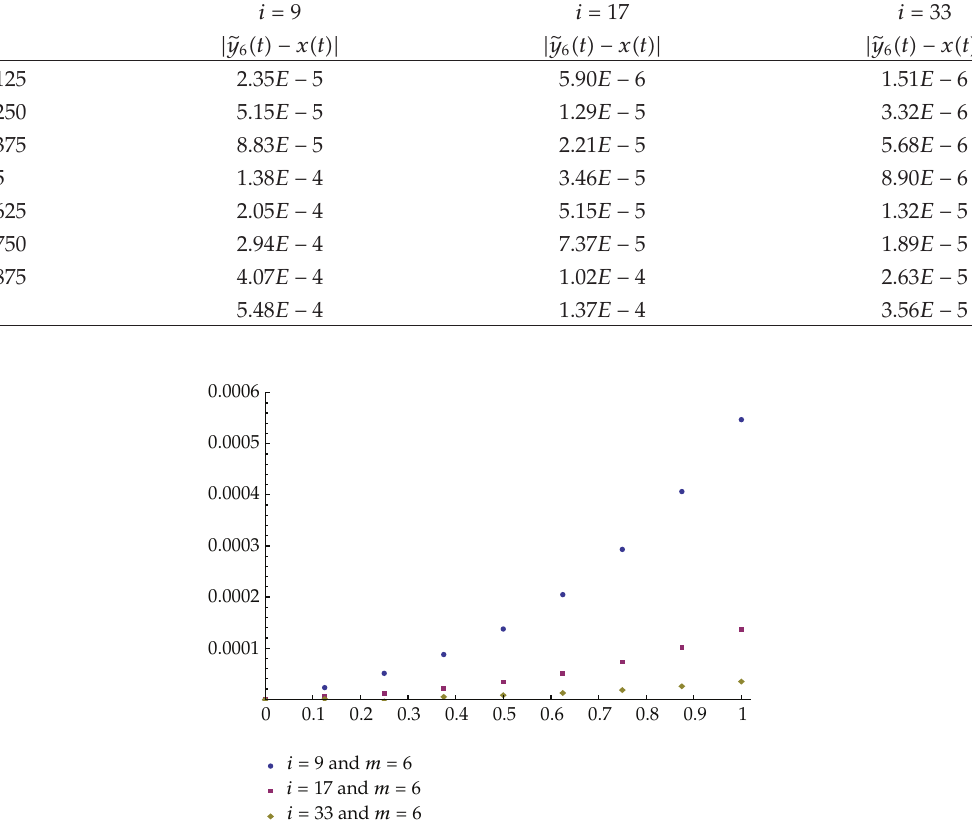
Figure 2: The plot of absolute errors by our method for Example